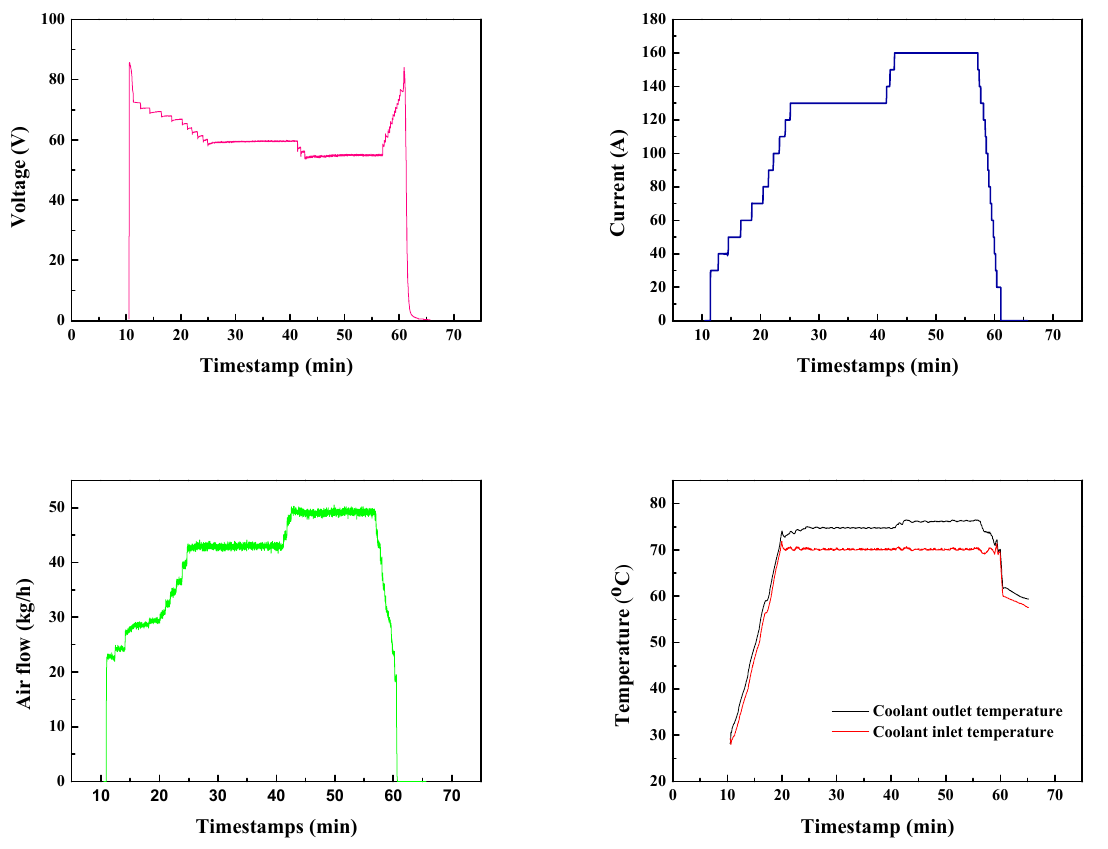
Figure 6. Fuel cell stack voltage variation and operation parameters of the PEMFC system.